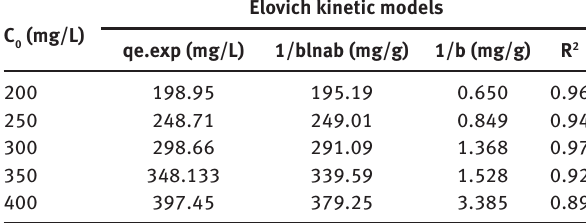
Figure 6: Van’t Hoff plot lnK adsorption on HSAAC.